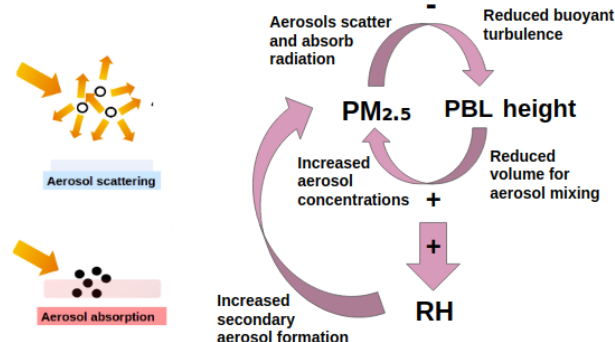
Figure 1. Schematic of the positive feedback loop between aerosols, radiation and meteorology thought to enhance pollution episodes in